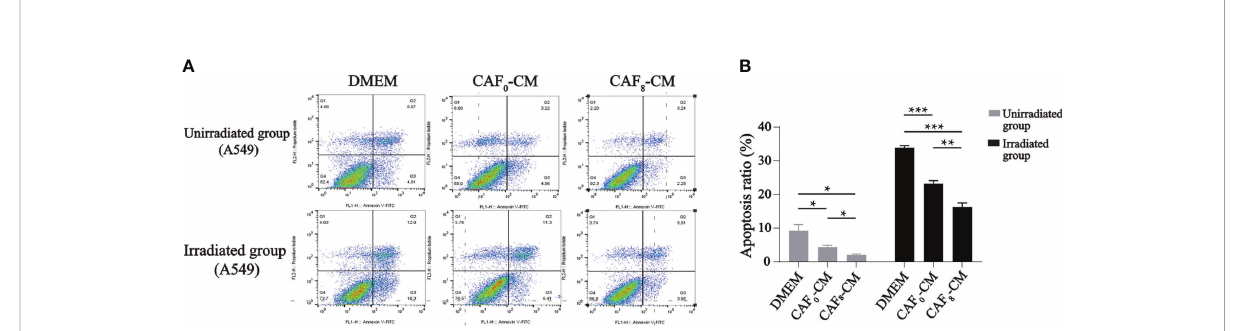
FIGURE 5 Flow cytometry analyzed the apoptosis of A549 cells received irradiation or not and treated with DMEM, CAF 0 -CM, CAF 8 -CM. (A) CAFs exhibited an inhibitory effect on A549 cells apoptosis, which showed more obvious in radiation-activated CAFs. In the unirradiated group, the CAF 8 -CM subgroup displayed more normal cells with less viable apoptotic cells. And when A549 received 6Gy irradiation, the number of the viable apoptotic cells in DMEM subgroup was twice as many as that in the CAF 8 -CM subgroup, which indicated the protective value of CAFs for irradiated A549; (B) A quantitative statistical analysis of the apoptotic cells in the different groups was carried out, and the bar graphs visualized the differences in apoptosis. (T-test, data are presented as the mean ± S.D. *P < 0.05, **P < 0.01, ***P <